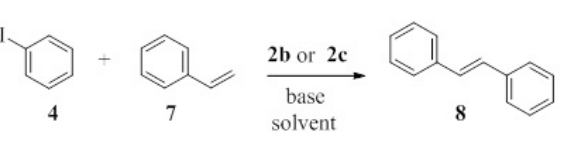
Figure 5 - Mirozoki-Heck reaction of 4 and 7 in palladacycles 2a , b